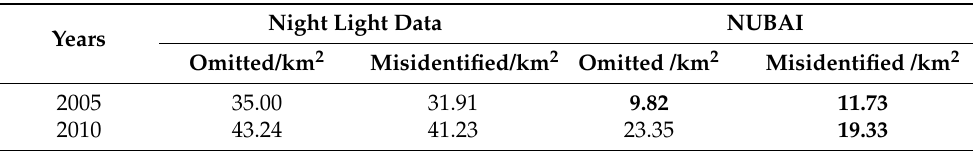
Table 2. Statistics of the omitted area sizes and misidentified area sizes.